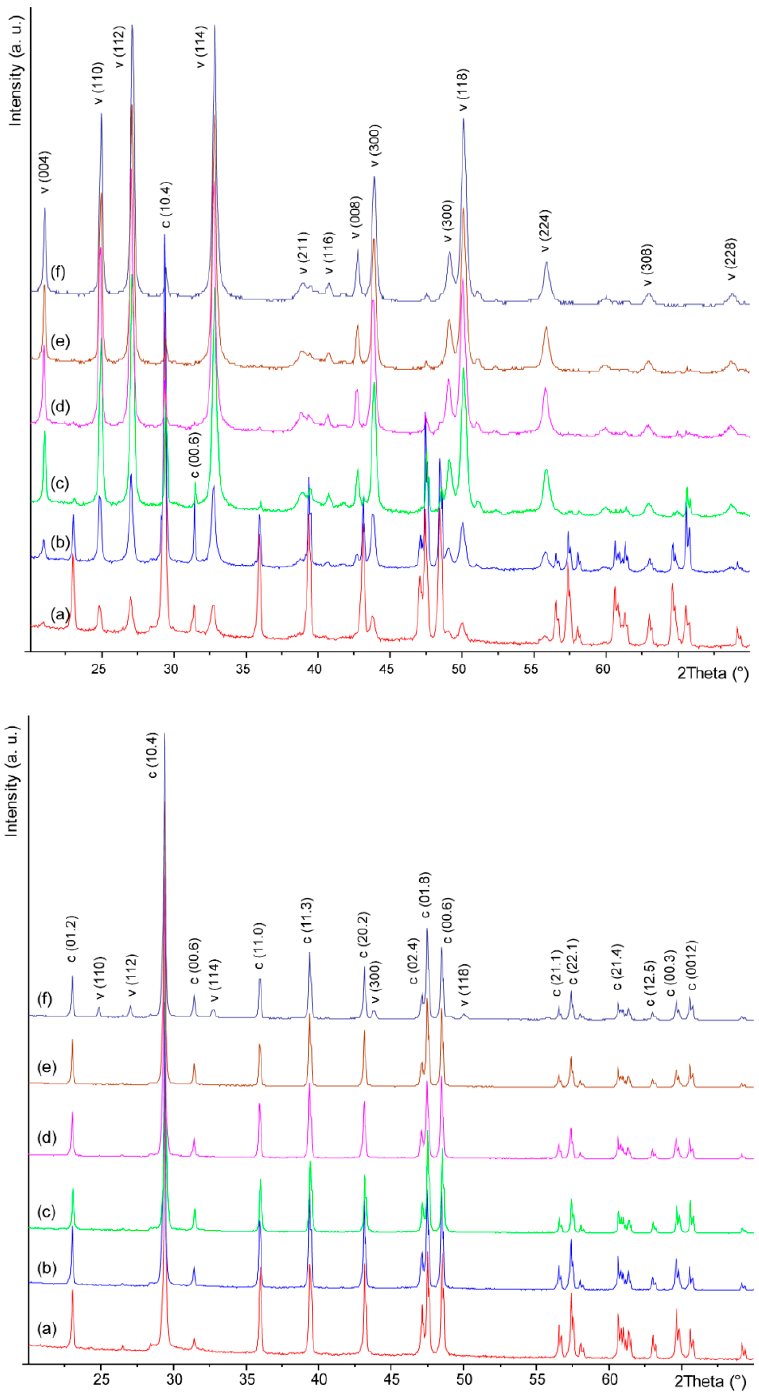
Figure 2. X-ray powder diffraction patterns of the precipitates obtained in the precipitation systems, c i (CaCl 2 ) = c i (NaHCO 3 ) = 0.1 mol · dm –3 , after 10 min ( top ) and 5 days of aging ( bottom ), in the presence of Li + at the concentration of (a) 0.0 mol · dm –3 , (b) 0.1 mol · dm –3 , (c) 0.3 mol · dm –3 , (d) 0.5 mol · dm –3 , (e) 0.7 mol · dm –3 or (f) 1.0 mol · dm –3 . The diffraction patterns were indexed accordingly to the PDF 00-005-0586 for calcite and PDF 00-033-0268 for vaterite PDF. In all systems only calcite and vaterite have been detected.